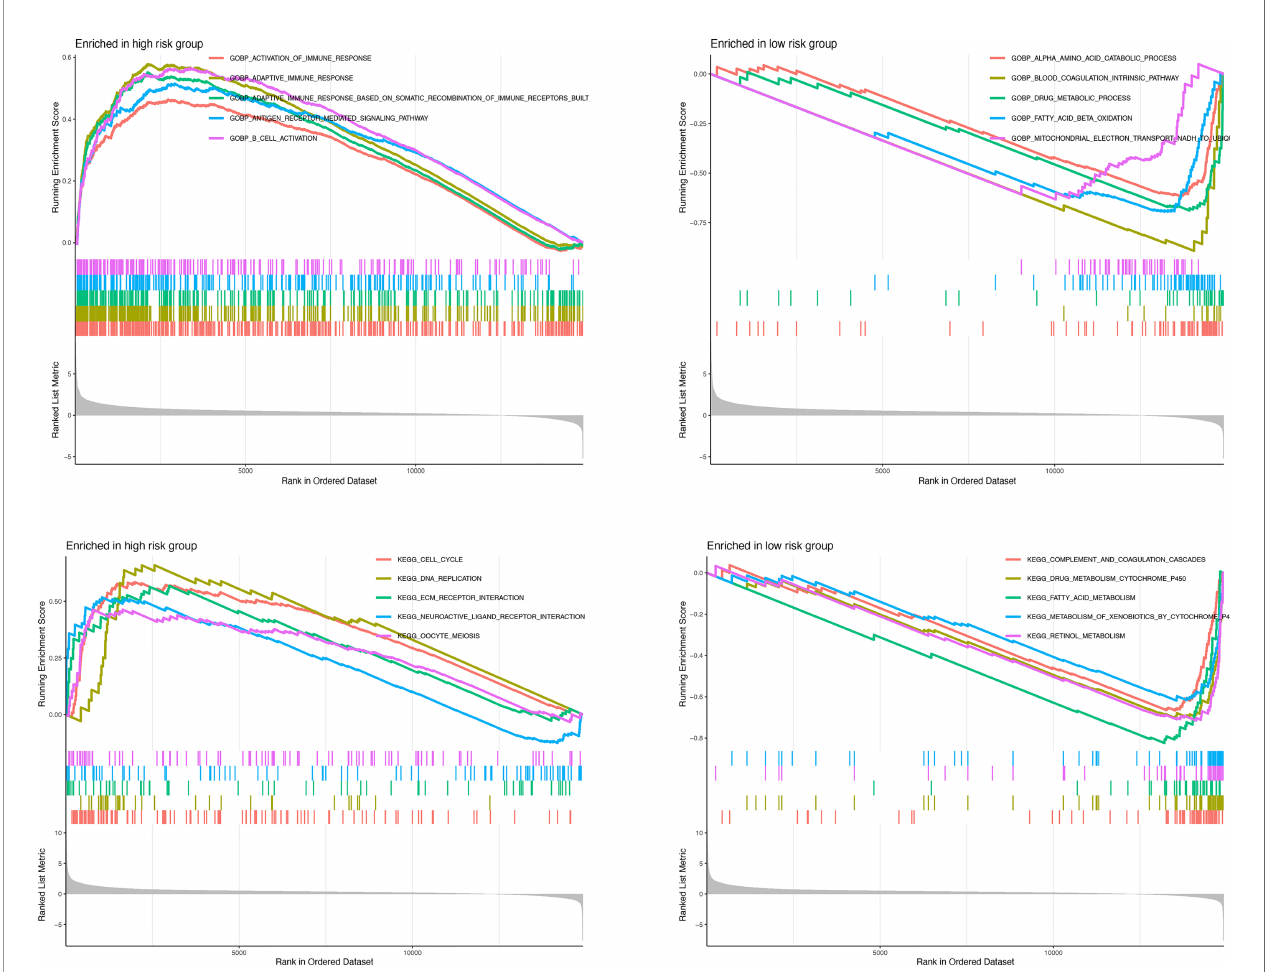
FIGURE 9 | Enrichment plots from gene set enrichment analysis in the high-risk groups and low-risk groups according to risk score based on macrophage- related